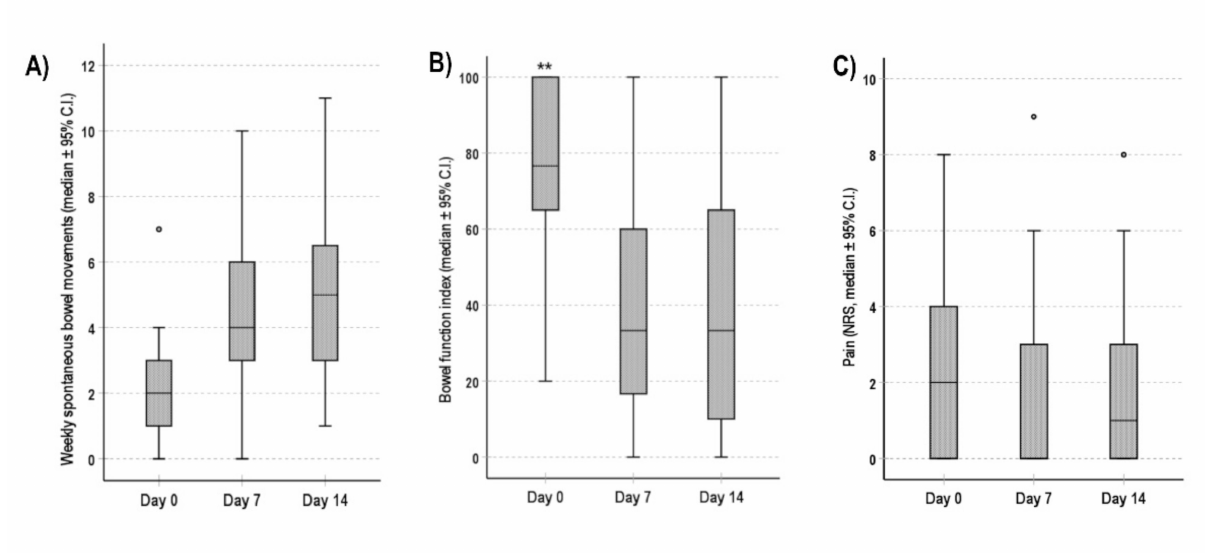
Figure 6. Bowel function and pain in dropout patients ( n = 20) during the first 2 weeks of follow-up. ( A ) Number of weekly spontaneous bowel movements, ( B ) BFI score, ( C ) Pain (NRS score). Data are shown as median (95% C.I.). ** p < 0.001 for the comparisons between values at day 0 and values at day 7 and